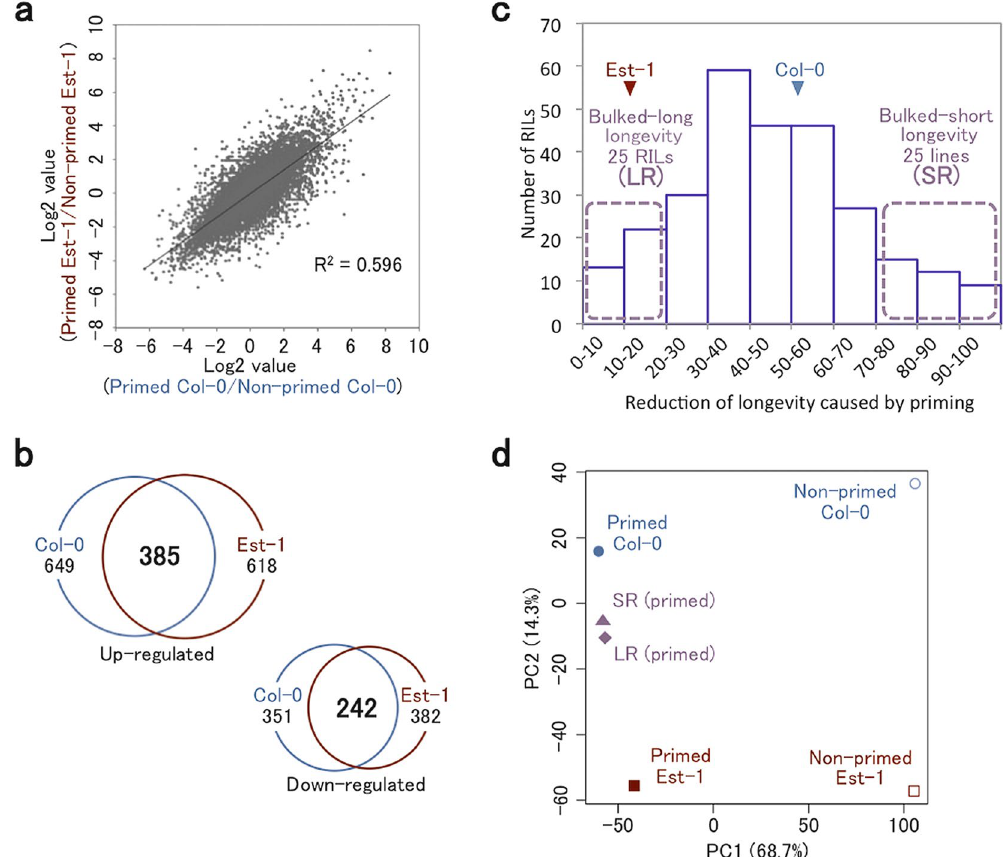
Figure 5. RNA-Seq analysis with seeds having different longevity. ( a ) Effect of priming on transcriptomes of Col-0 and Est-1 seeds. Fold changes in the gene expression levels by priming were compared between Col-0 and Est-1. ( b ) Comparison of top 1,000 genes whose expression was up- or down-regulated by priming between Col-0 and Est-1. ( c ) Frequency distribution of reduction rates of seed longevity after priming for the population of 279 RILs. The top 25 RILs with the greatest reduction were bulked as short RILs (SR). The top 25 RILs with the smallest reduction were bulked as long RILs (LR). ( d ) PCA of six transcriptome data obtained by RNA-Seq.